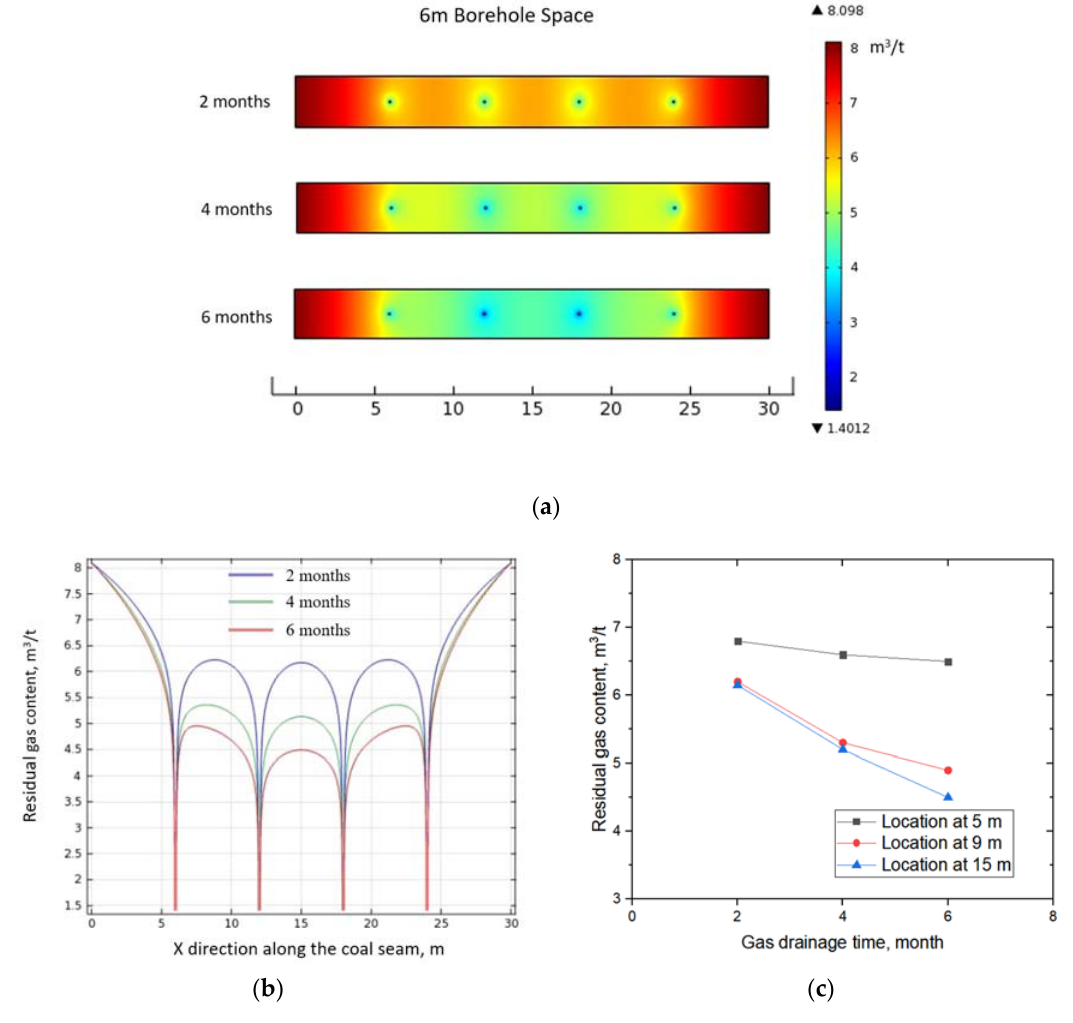
Figure 9. Simulation results of the 6 m borehole. ( a ) Gas content contour; ( b ) residual gas content with respect to X direction along the coal seam; ( c ) gas content at three points with respect to gas drainage time. Table 7. Gas drainage-affected coal seam